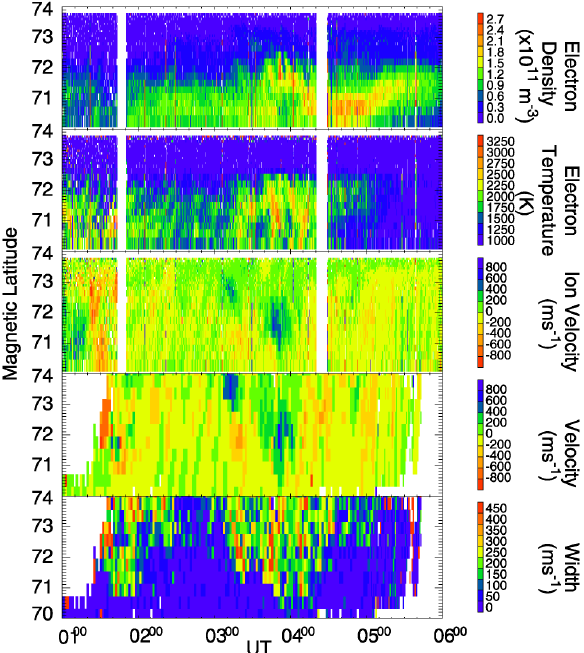
Fig. 6. The north-south component measurements from five of the IMAGE magnetometer stations filtered between 100s and 1000s, 20 December 1998.